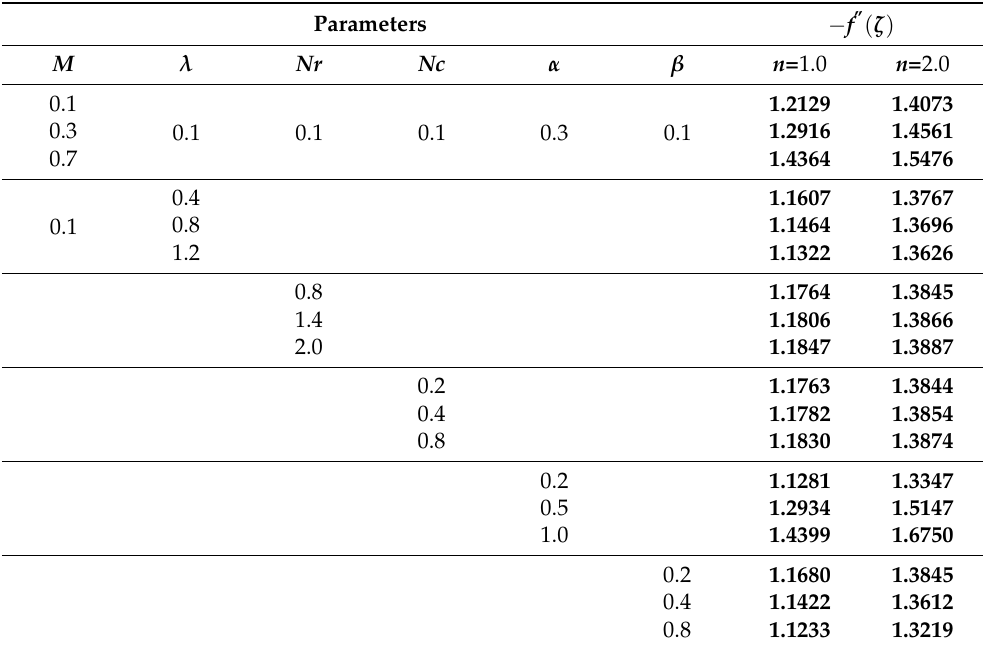
Table 1. Effect of flow factor over local velocity coefficient − f (cid:48)(cid:48) ( ζ ) at ζ = 0.